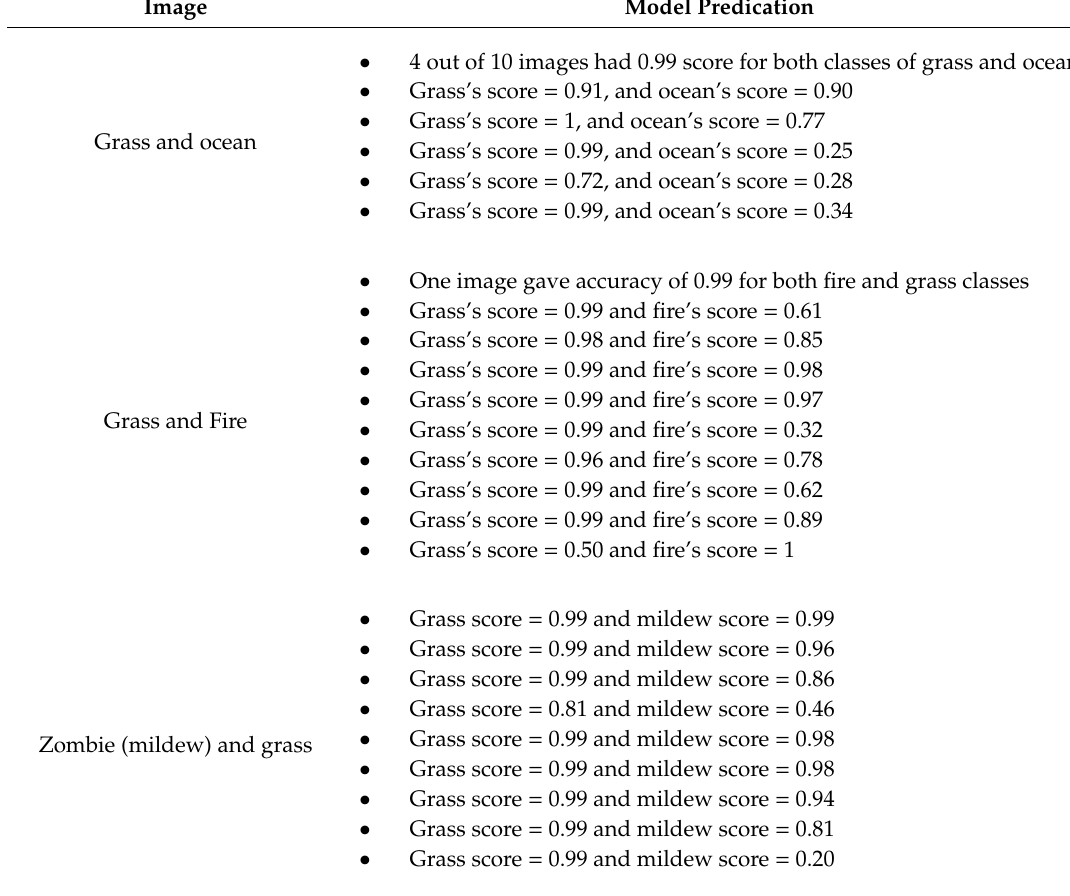
Table 3. Model predications for 10 testing images of